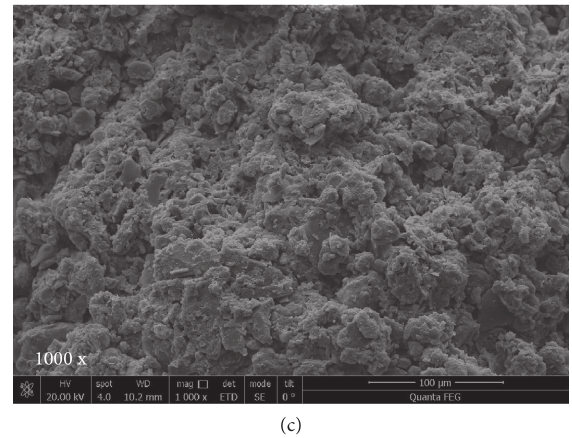
Figure 16: Micrographs of loess specimens after the triaxial tests. (a) I-300-0%. (b) C-400-20%. (c)